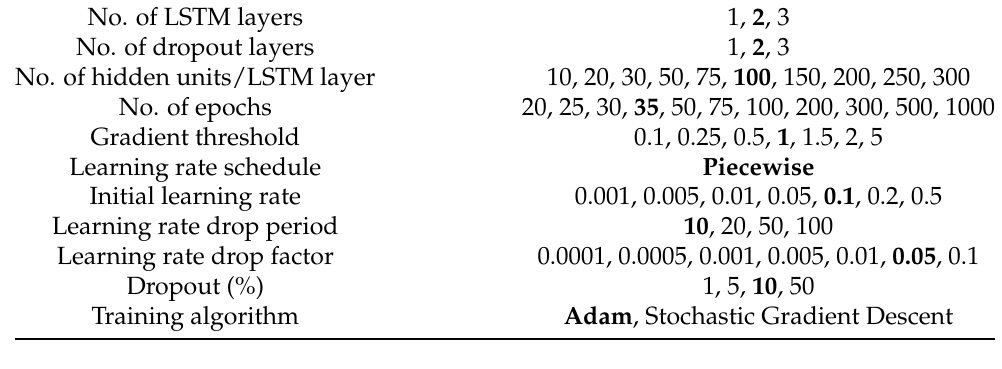
Table 1. Hyperparameters tested for the LSTM structure. Bold entries represent the selected hyper- parameters.